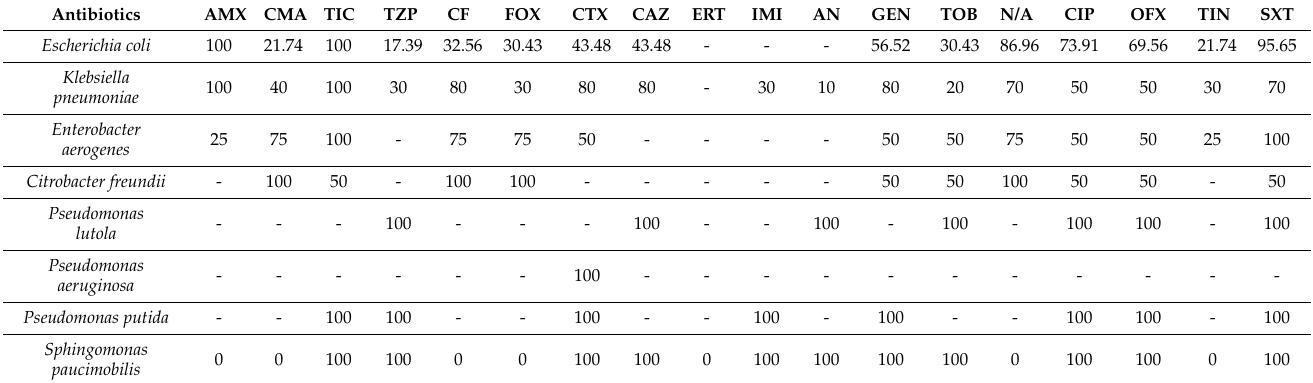
Table 8. Resistance profile (%) of enterobacteria and non-enterobacteria strains to the antibiotics used.